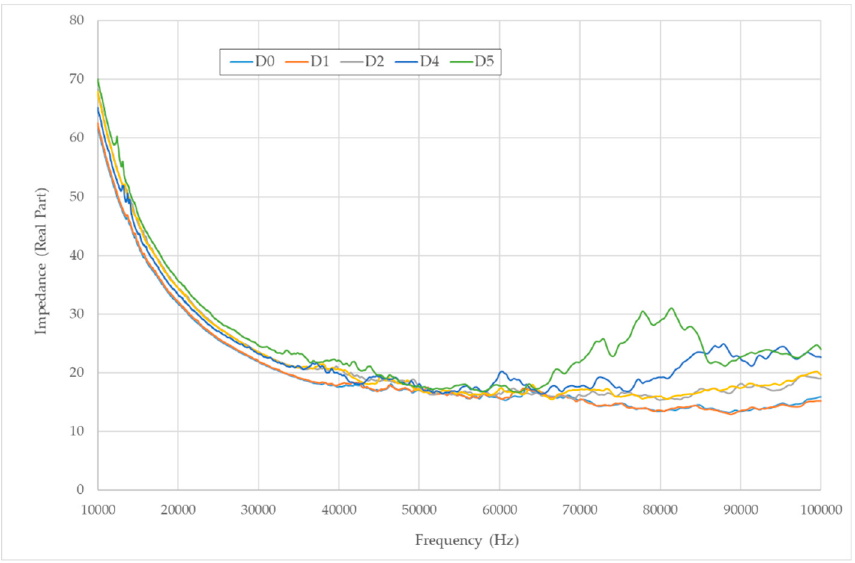
Figure 8. Change of the impedance signal for PZT9 along the different damage stages.